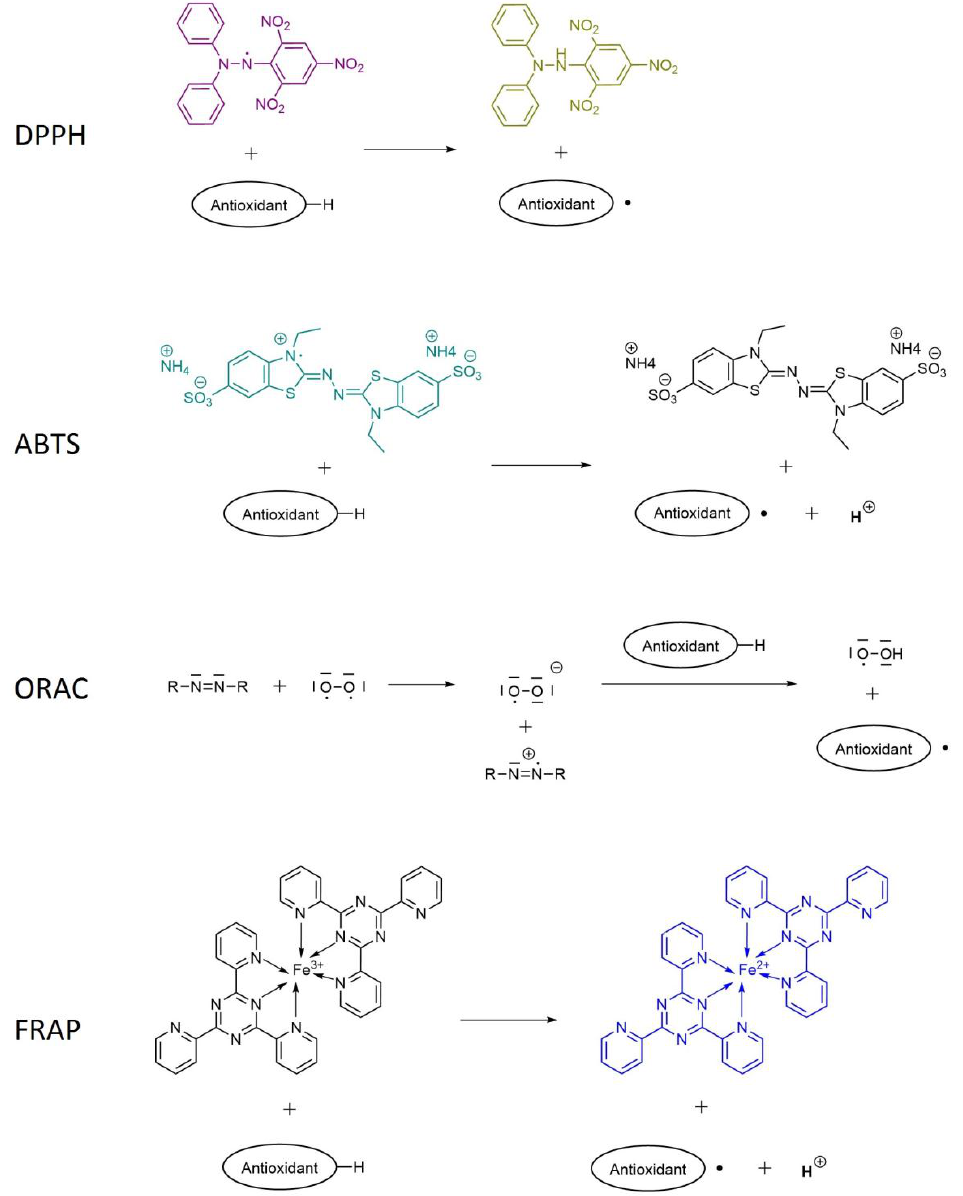
Figure 5. Chemical reaction involved in the most used scavenging assays 1